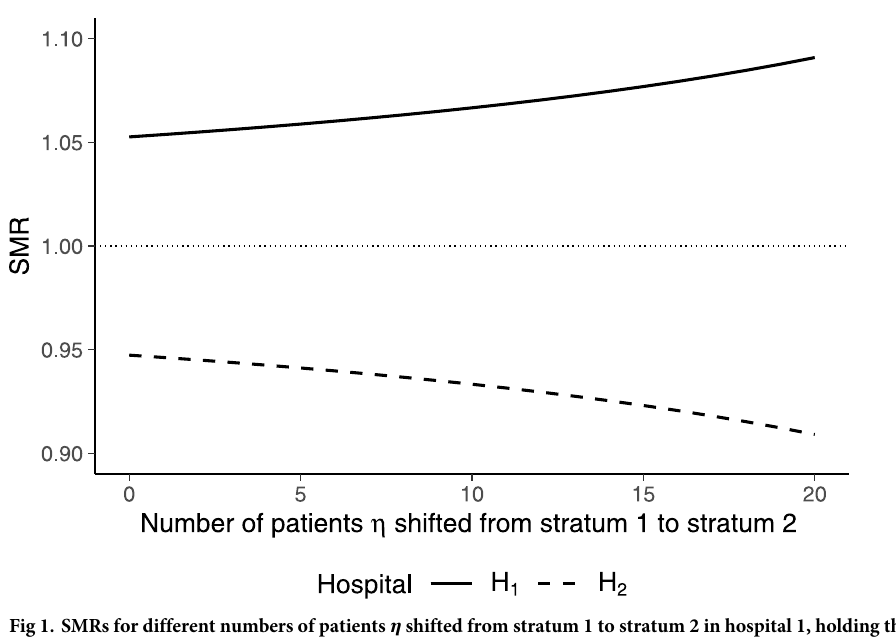
Fig 1. SMRs for different numbers of patients η shifted from stratum 1 to stratum 2 in hospital 1, holding the number of patients belonging to stratum 3 constant.